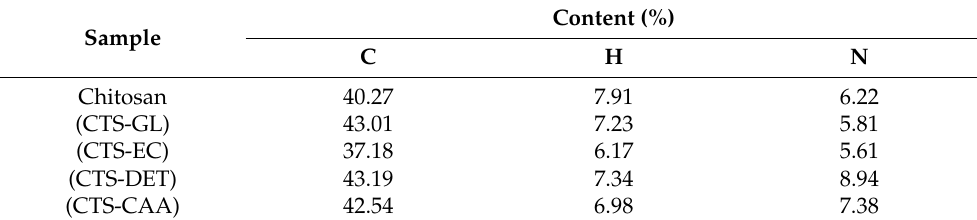
Table 1. Elemental analysis for chitosan and modified chitosan